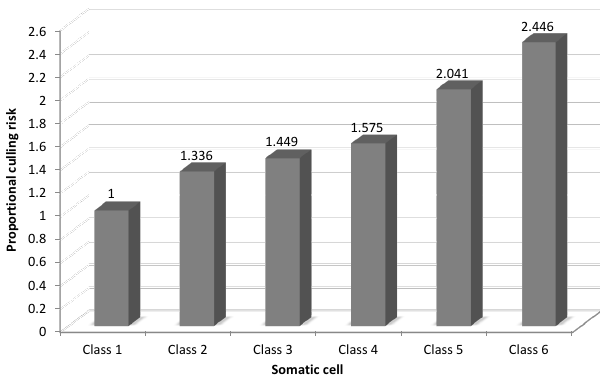
Figure 3. Interaction between parity × stage of lactation and proportional culling risk